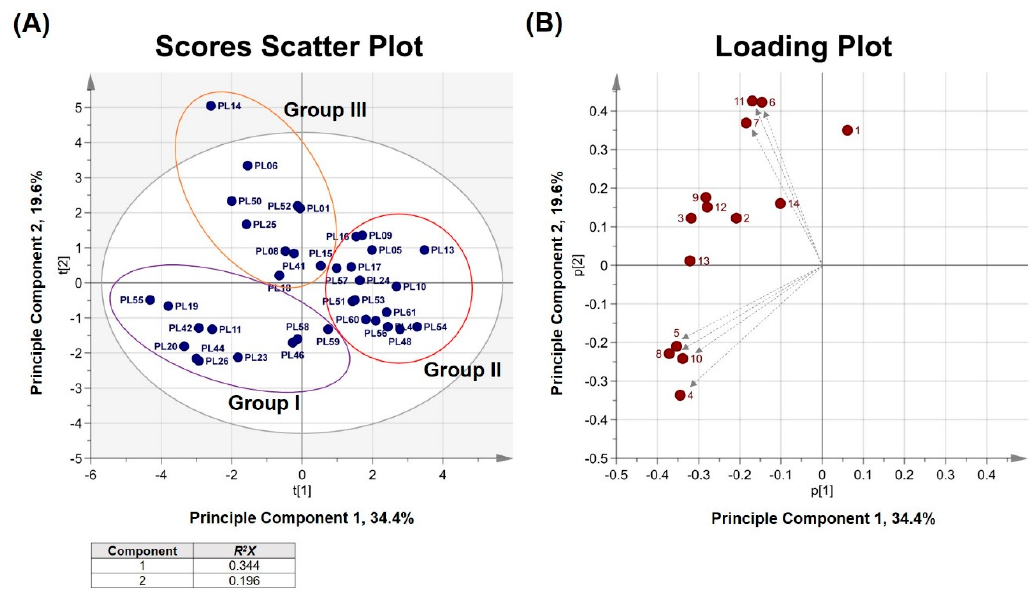
Figure 2. ( A ) Principal component analysis (PCA) scores scatter and ( B ) loading plots for the wheat sprout samples.